Question: Give a one-sentence summary of this figure.
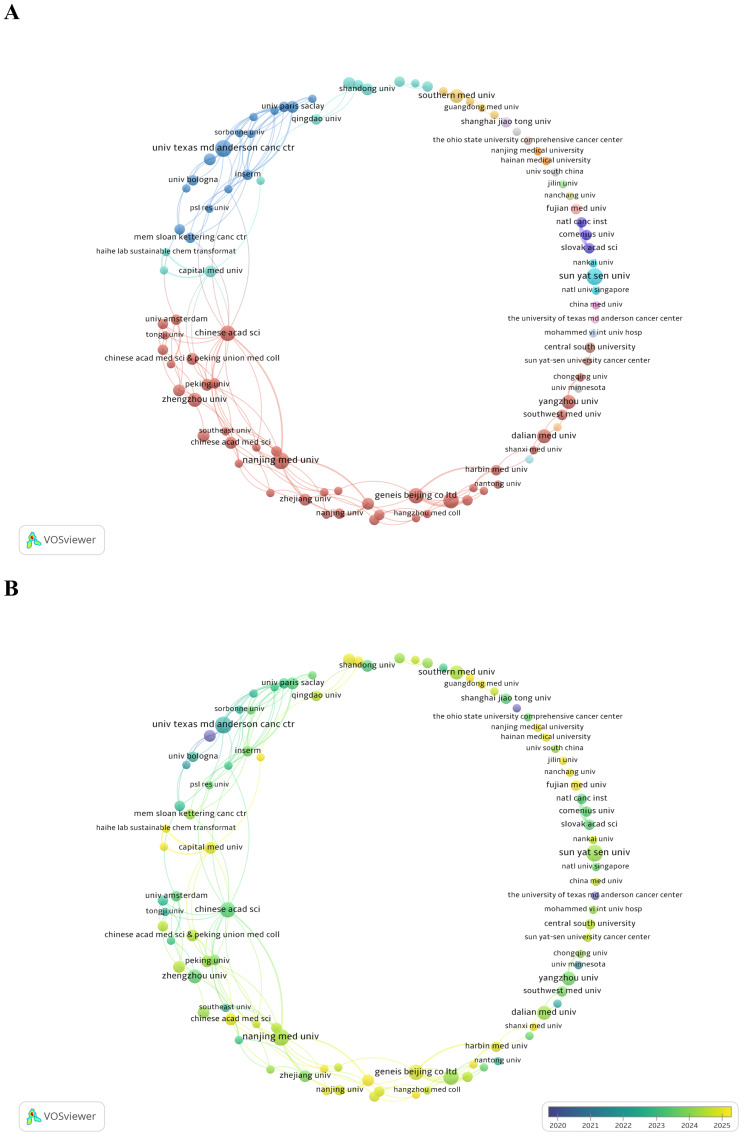
Answer: Institutional collaboration patterns and temporal evolution. (A) Collaboration network of institutions with at least two publications. Node size is proportional to publication output; edge thickness represents collaboration strength. Node colors indicate distinct collaboration clusters. (B) Temporal overlay of the institutional collaboration network. Node color gradient from blue (earlier average publication year) to yellow (later average publication year).